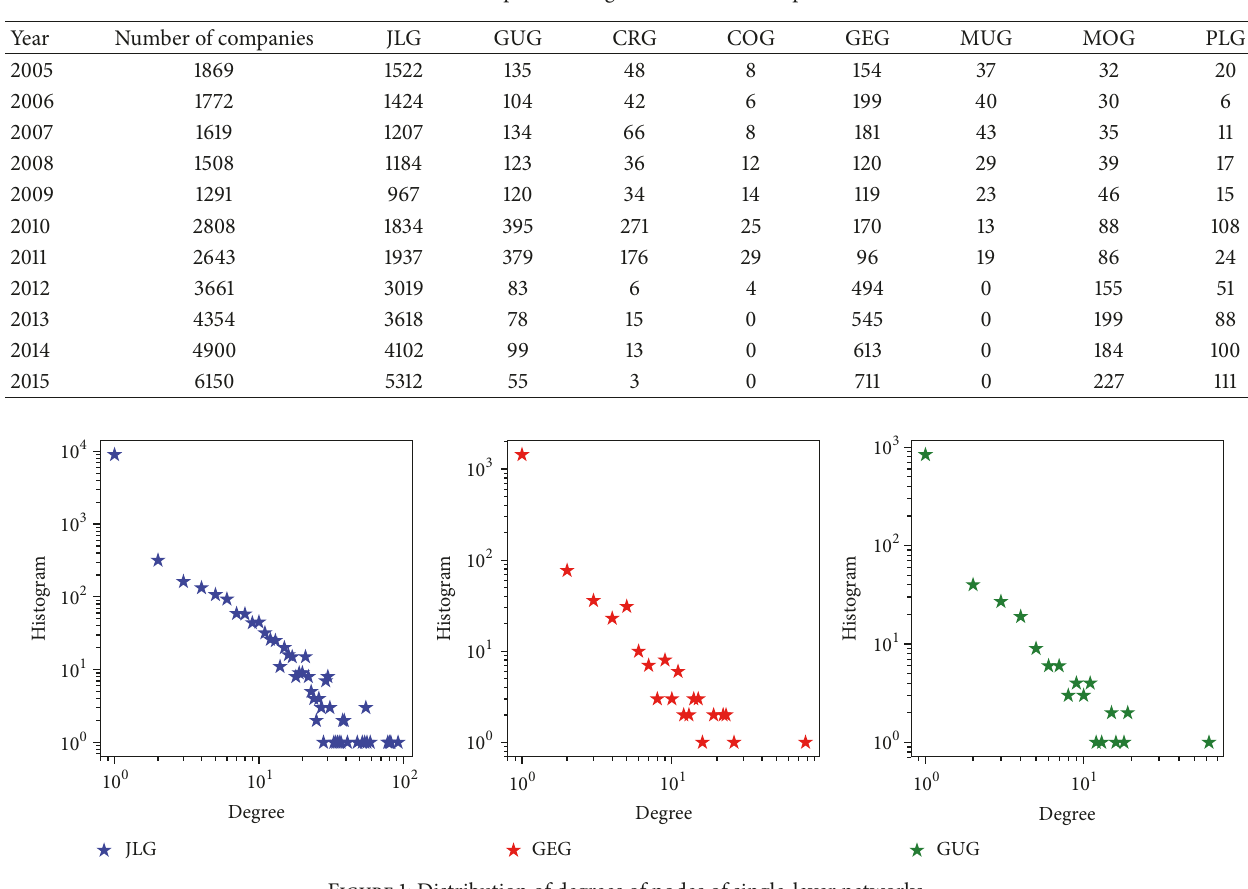
Figure 1: Distribution of degrees of nodes of single-layer